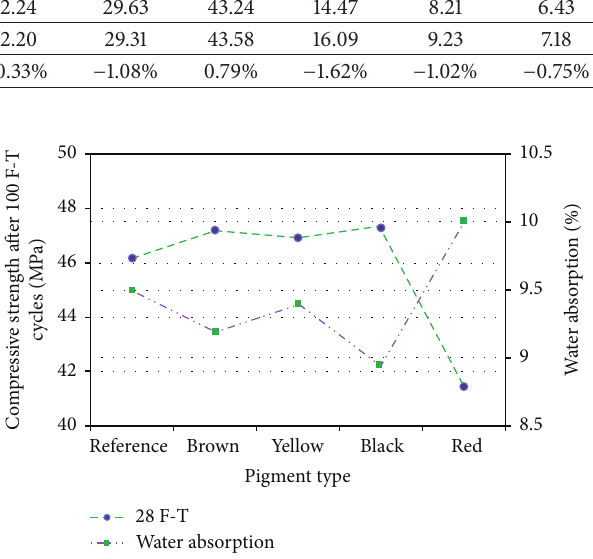
Figure 4: The impact of pigment type on the F-T process (samples cured for 28